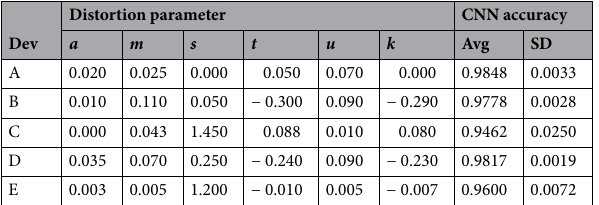
Table 2. Fitting parameter values and obtained network accuracy for five measured devices.